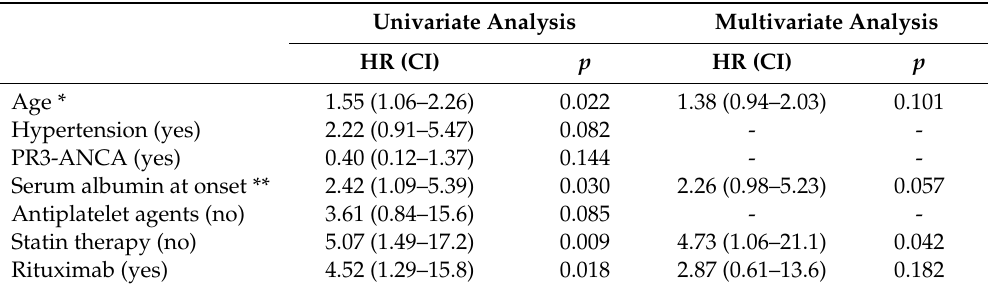
Table 4. Univariate and multivariate analysis of risk factors associated with occurrence of venous thromboembolic